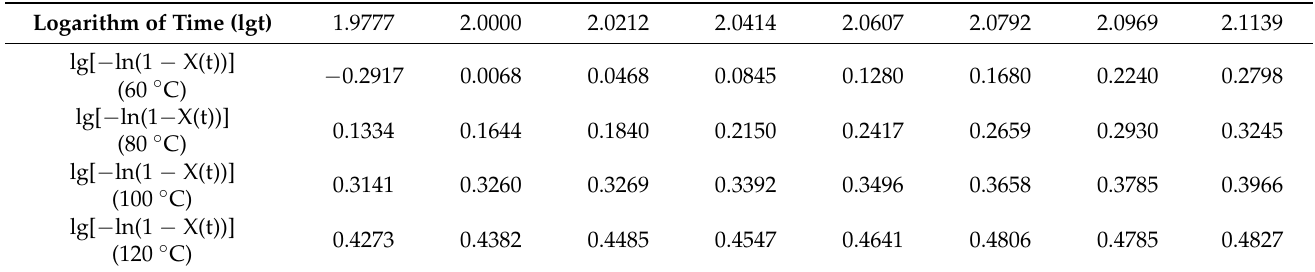
Table 5. The relationship between lg [ − ln (1 − X (t))] and lgt at different temperatures.